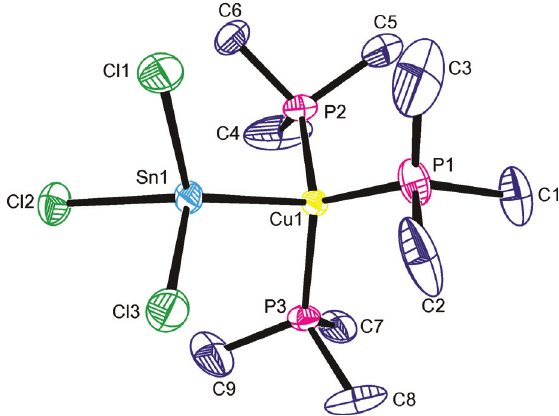
Figure 5 One of four similar molecules that constitute the asym- metric unit of 5 showing the labeling scheme used. Thermal ellipsoids are at the 40% probability level; hydrogen atoms have been omitted for clarity. Selected geometric data: